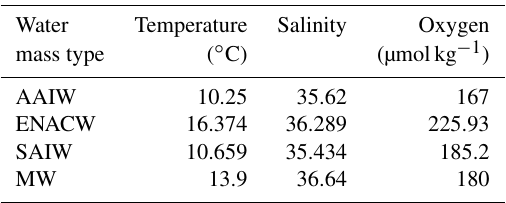
Table 2. Values of physical–chemical variables taken for the differ- ent water